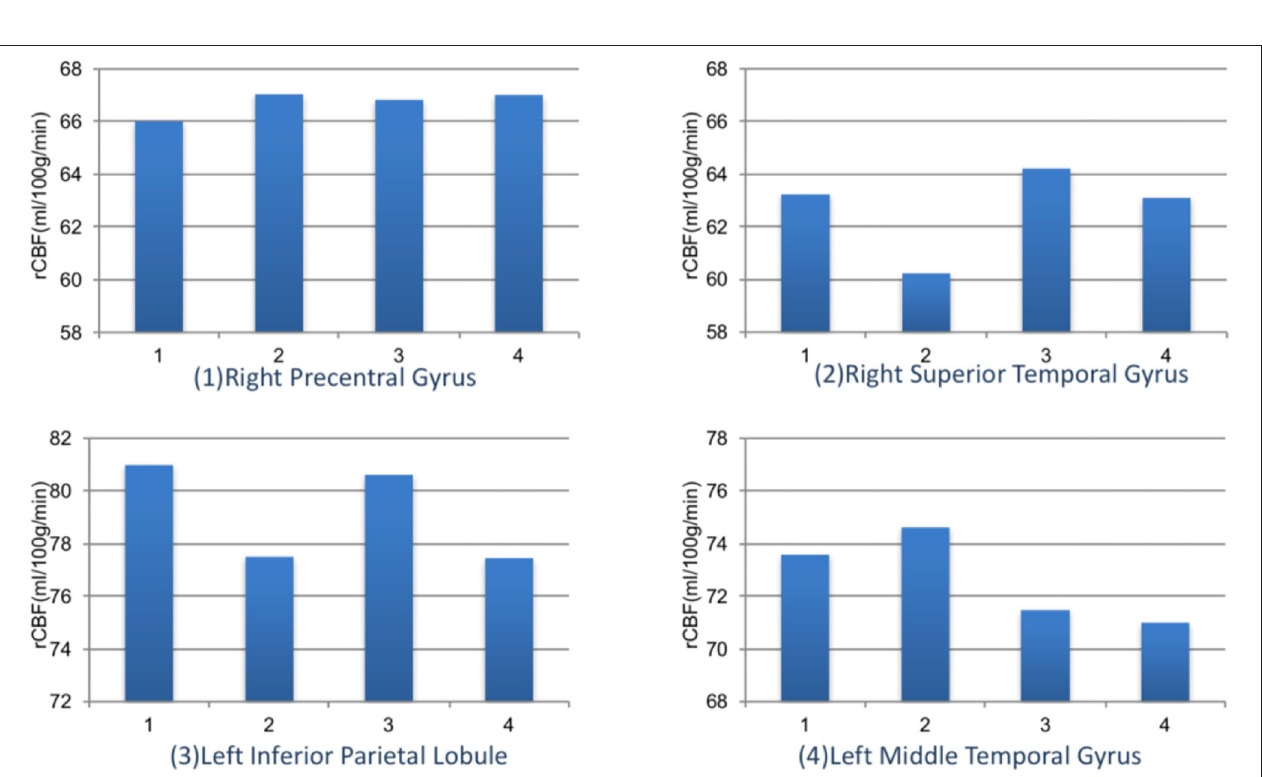
FIGURE 5 | The rCBF signal intensity (ml/100 g/min) changes in four ROIs among different refractive groups. Group 1: emmetropia, Group 2: low myopia, Group 3: moderate myopia, and Group 4: high myopia.